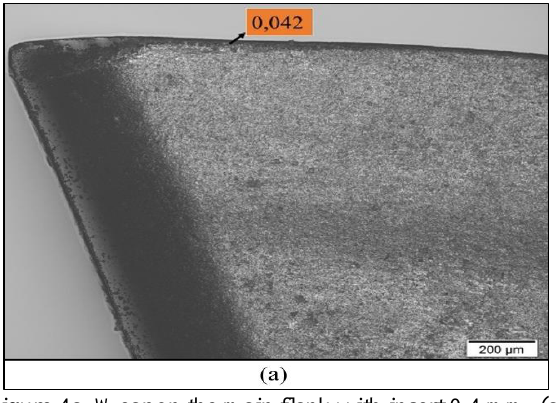
Figure 4a: Wear on the main flank with insert 0,4 mm: (a) Without sealant.